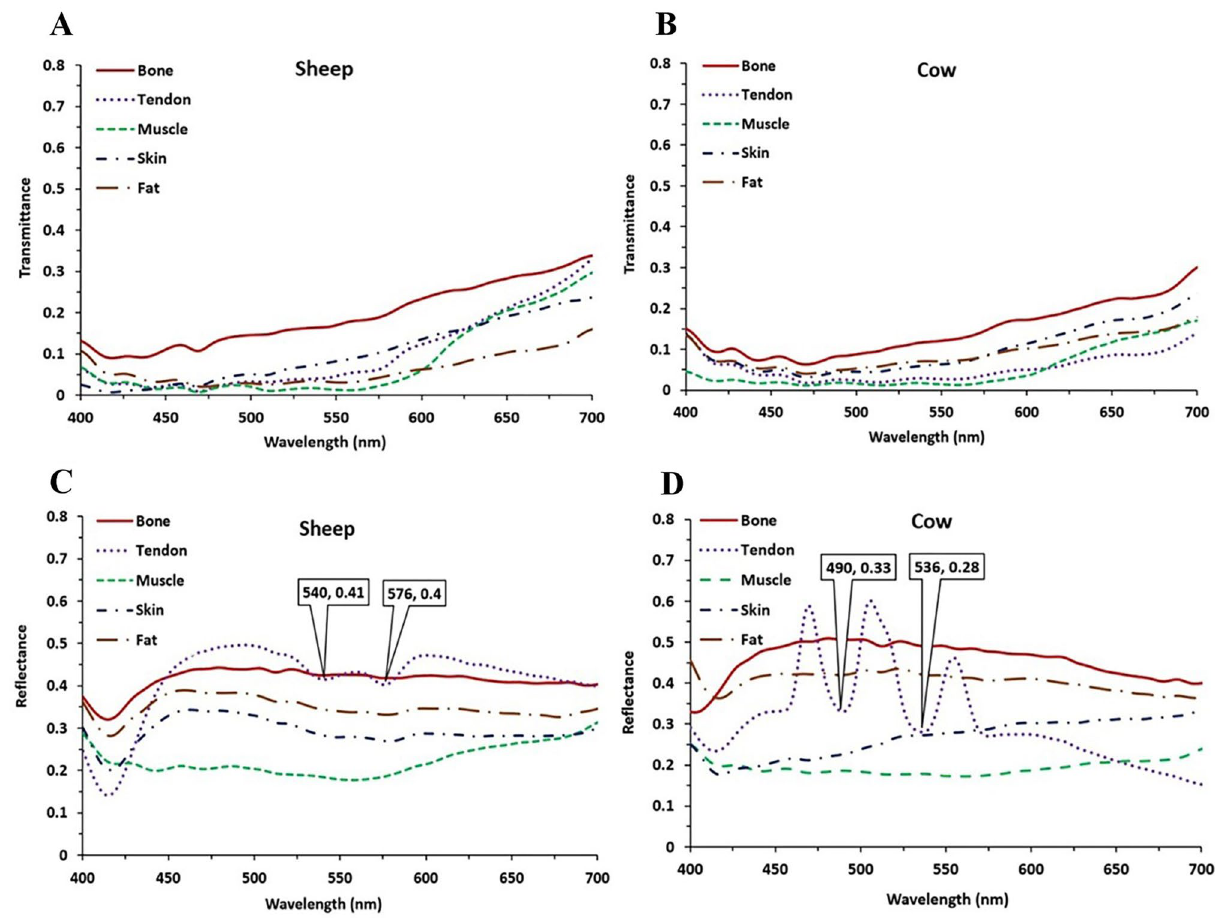
Figure 8 . Spectral behavior of biological tissue in the range of 400 to 700 nm, transmittance spectrum of ( A ) sheep and ( B ) cow samples, reflectance spectrum of ( C ) sheep and ( D ) cow samples. Procedure time Sample number